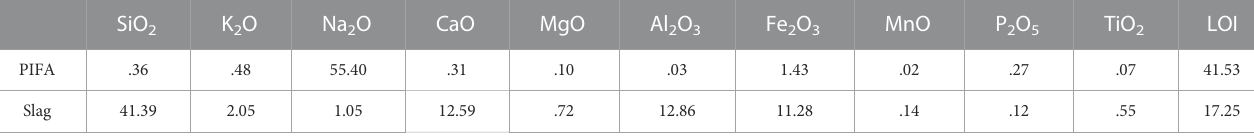
TABLE 1 Chemical composition of the coal gasi fi cation slag and petrochemical incineration fl y ash (wt%).